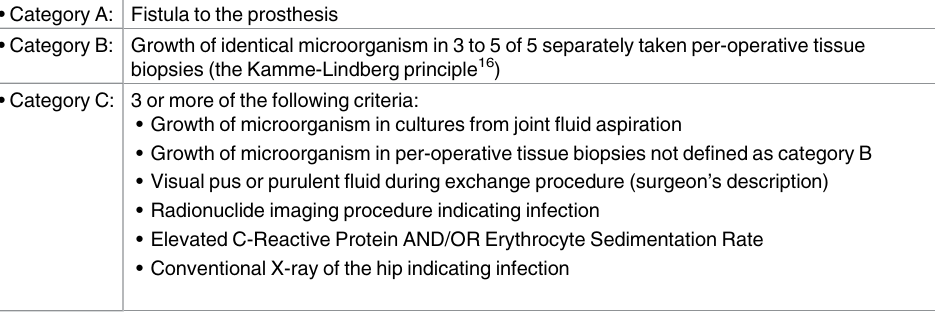
Table 1. Definition of periprosthetic hip joint infections in the 130 identified